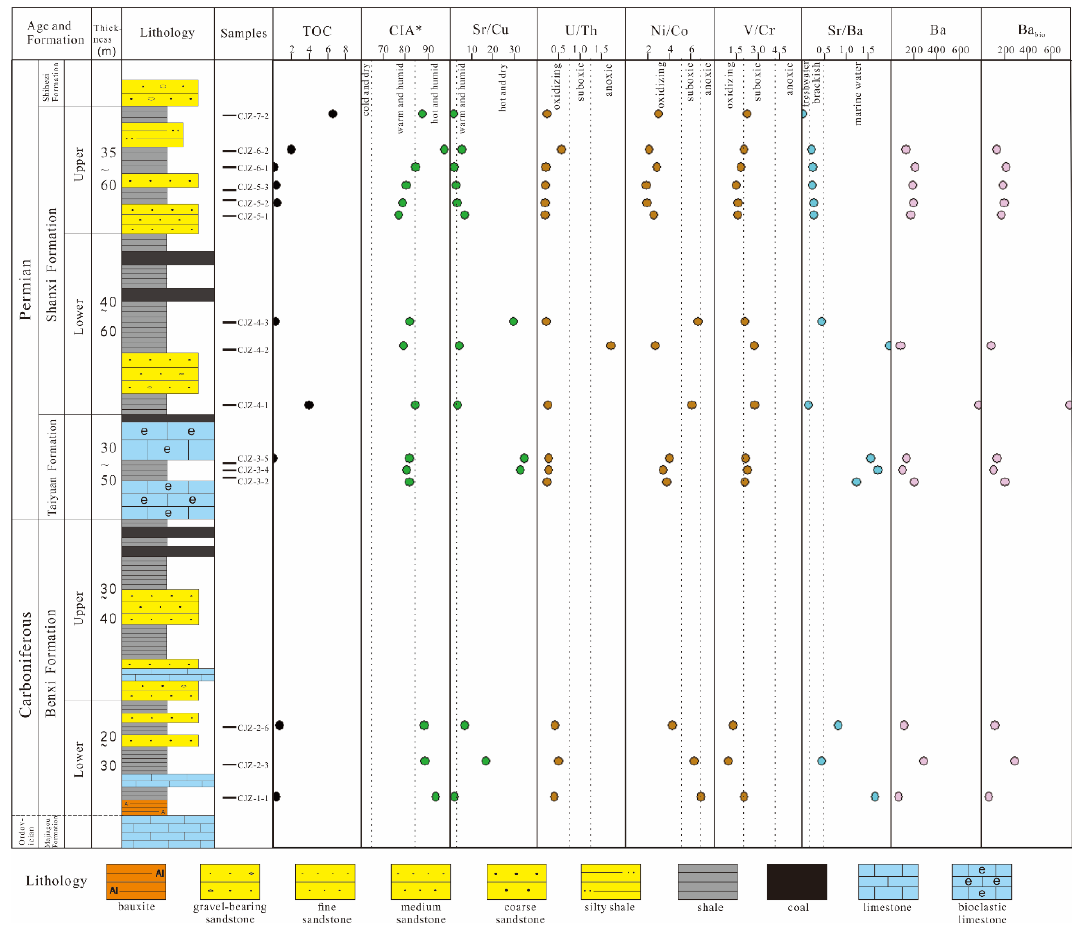
Figure 3. Carboniferous–Permian stratigraphic column for the Liulin section. Table 2. Mineral compositions of the shales